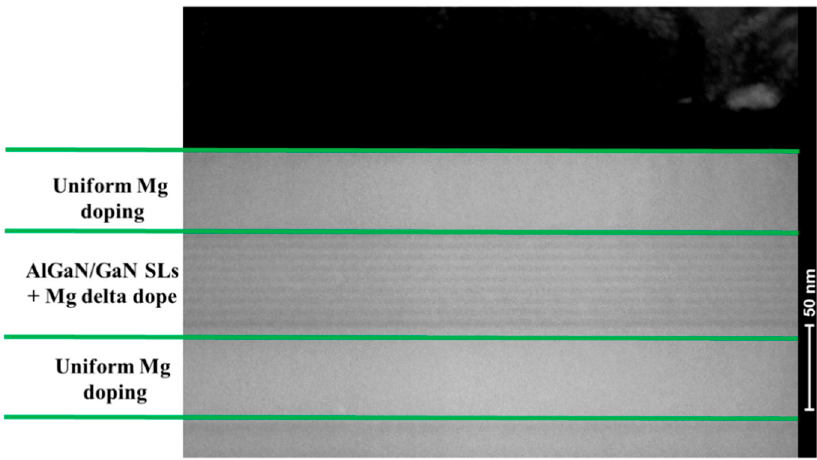
Figure 3. Cross-sectional TEM image of the p-type layer of sample B.